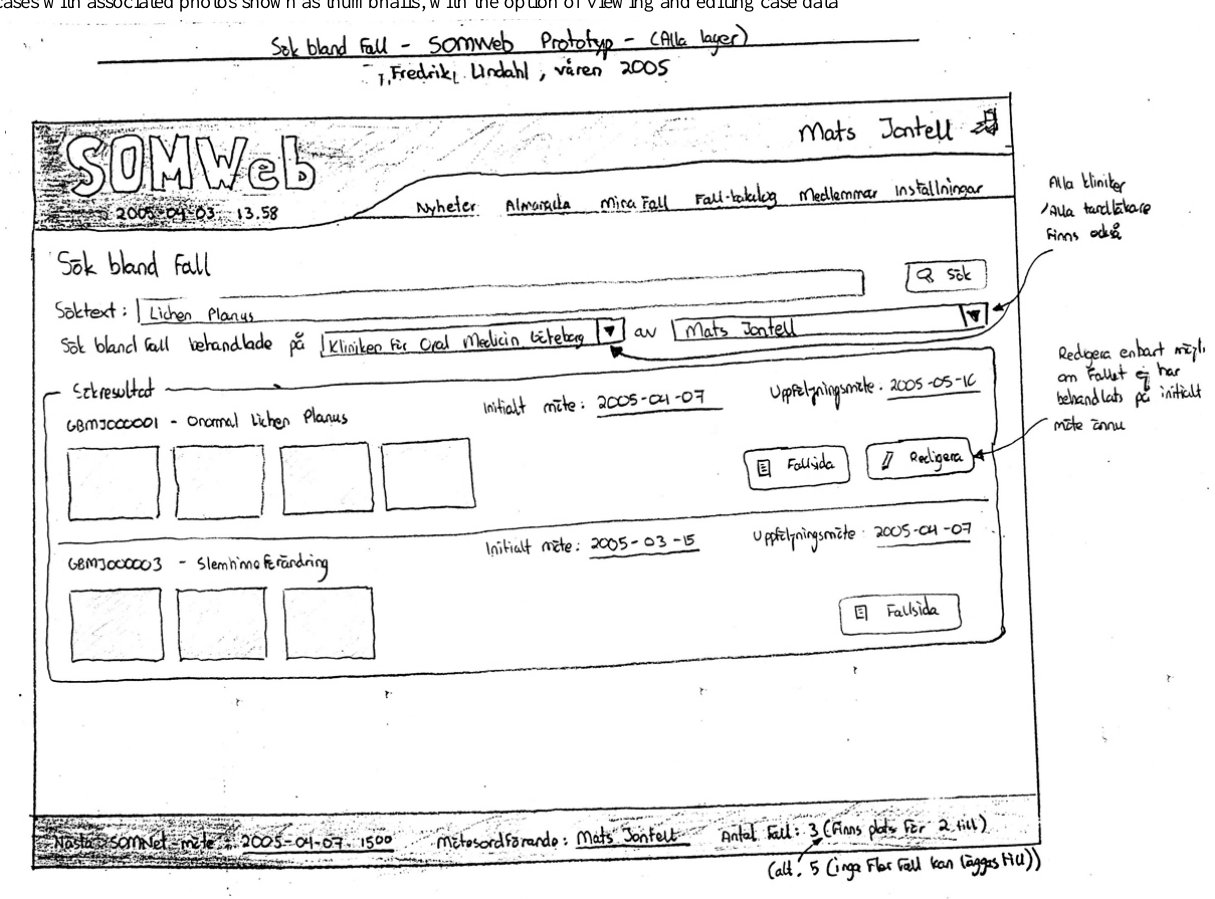
Figure 1. A paper prototype of SOMWeb that shows a text-based search function, restricted to a specified clinic and clinician, which results in a list of cases with associated photos shown as thumbnails, with the option of viewing and editing case